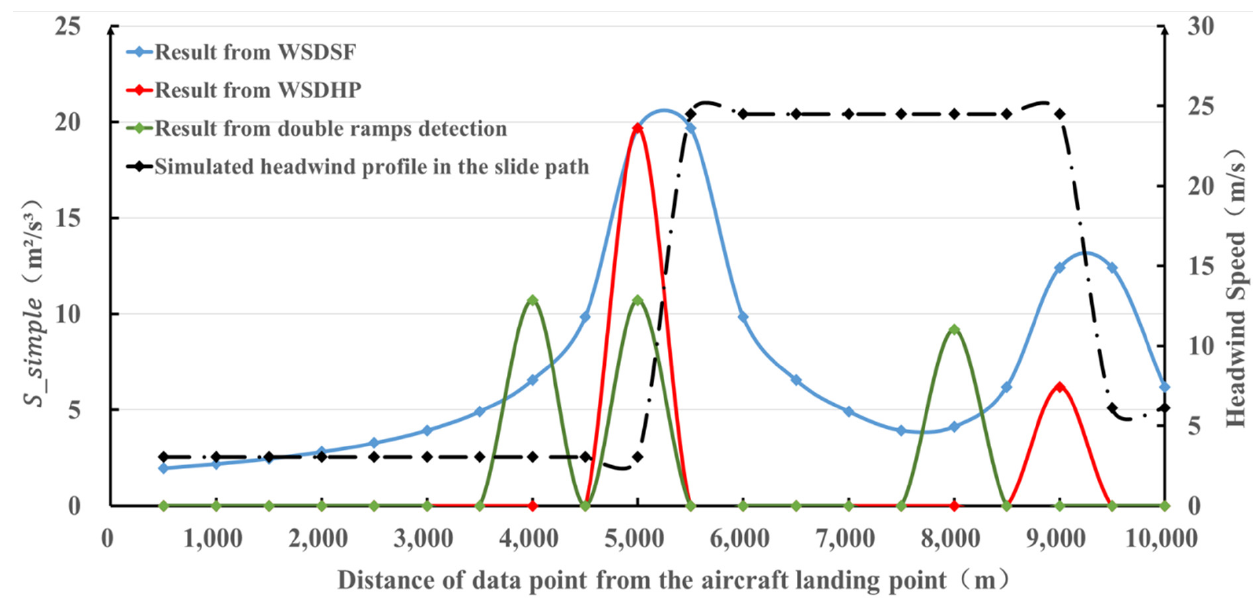
Figure 11. The results of wind shear detection under the low-level jet wind field background.